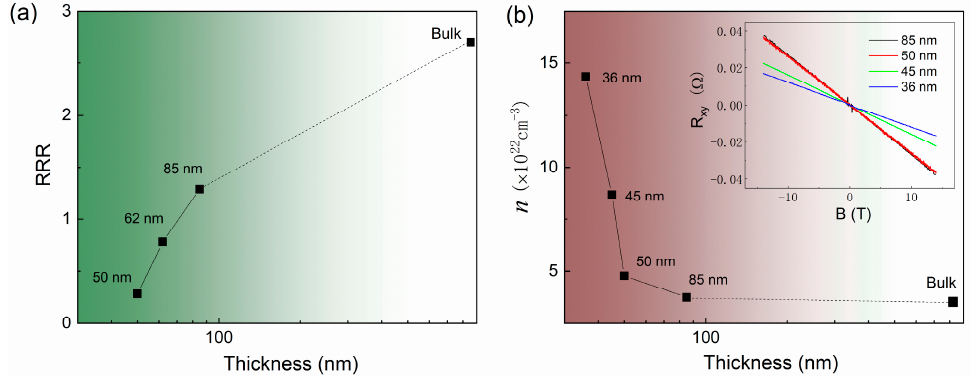
Figure 5. ( a ) The thickness dependence of residual resistance ratio ( RRR ) in β -PdBi 2 . ( b ) The thickness dependence of carrier concentration in β -PdBi 2 . The inset shows the Hall resistance of various thickness at T = 2